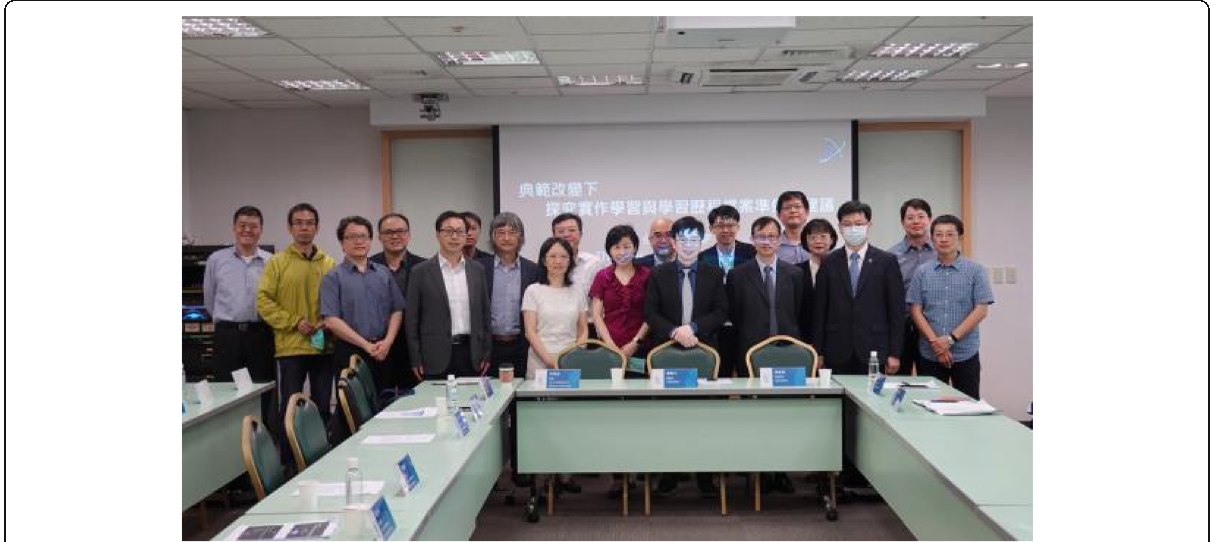
Fig. 7 The second press conference to respond to the “ 108 Curriculum ” was held at Taipei, Taiwan on March 29,